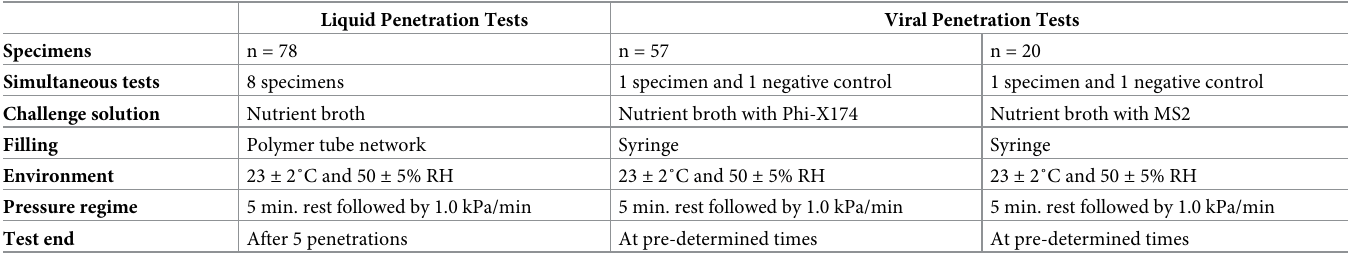
Table 2. Summary of liquid and viral penetration